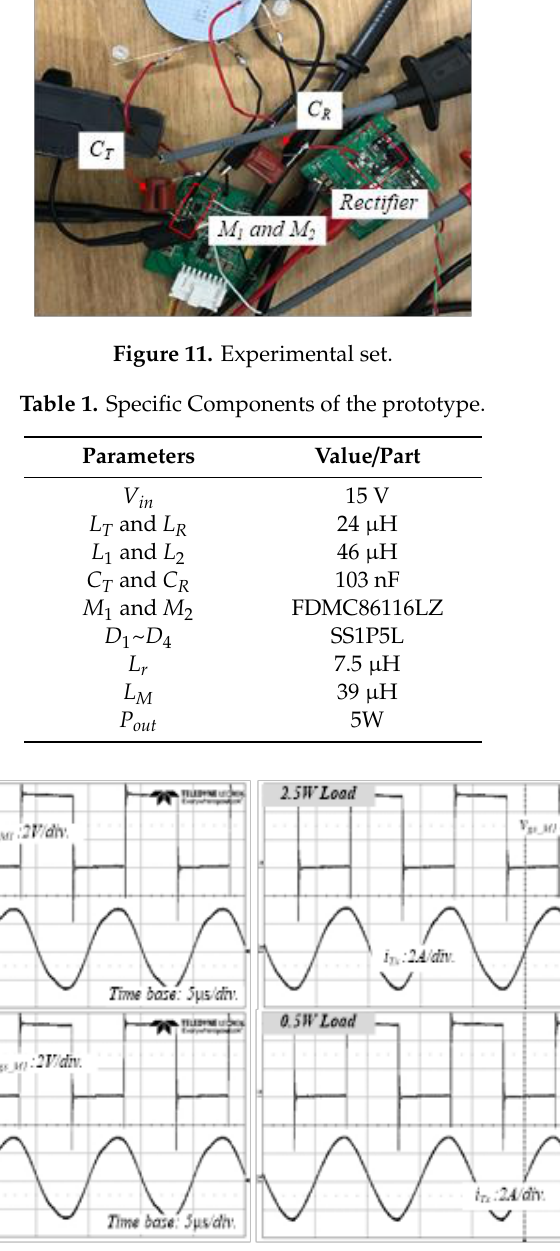
Figure 12. Experimental waveforms in the critical coupling condition.